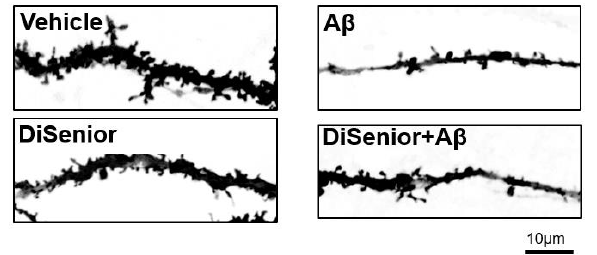
Figure 3. Disenior TM does not ameliorate loss of spine density induced by Amyloid-Beta.